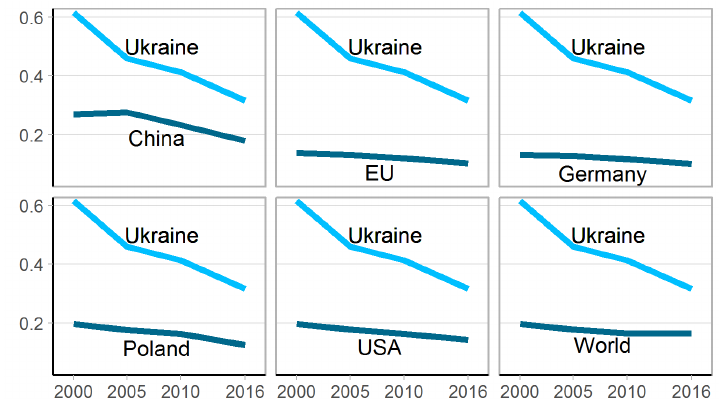
Energies 2018 , 11 , x FOR PEER REVIEW 19 of 33 32%. Instead, the consumption of renewable energy sources increased by 52% over the studied Figure 7. Dynamics of the level of energy intensity of GDP in 2000–2016 in kg of oil equivalent per 1 Figure 7. Dynamics of the level of energy intensity of GDP in 2000–2016 in kg of oil equivalent per 1 period, while the share of renewable energy in total energy consumption increased by 2.31 times. USD per purchasing power parity of 2005. Source of information: [89]. USD per purchasing power parity of 2005. Source of information: [89].